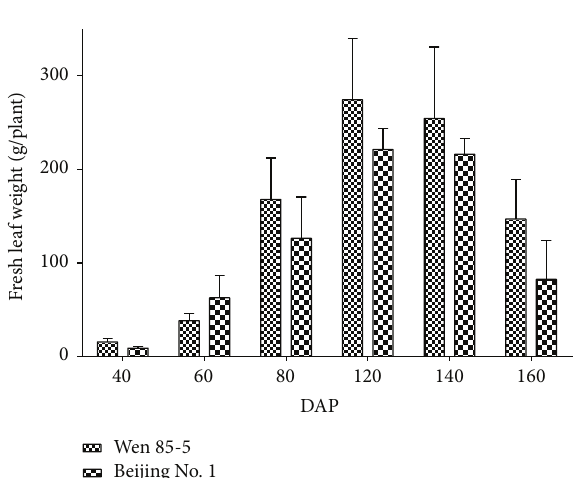
Beijing No. 1 Figure 2: Changes of fresh weight of R. glutinosa leaves during the growth period.